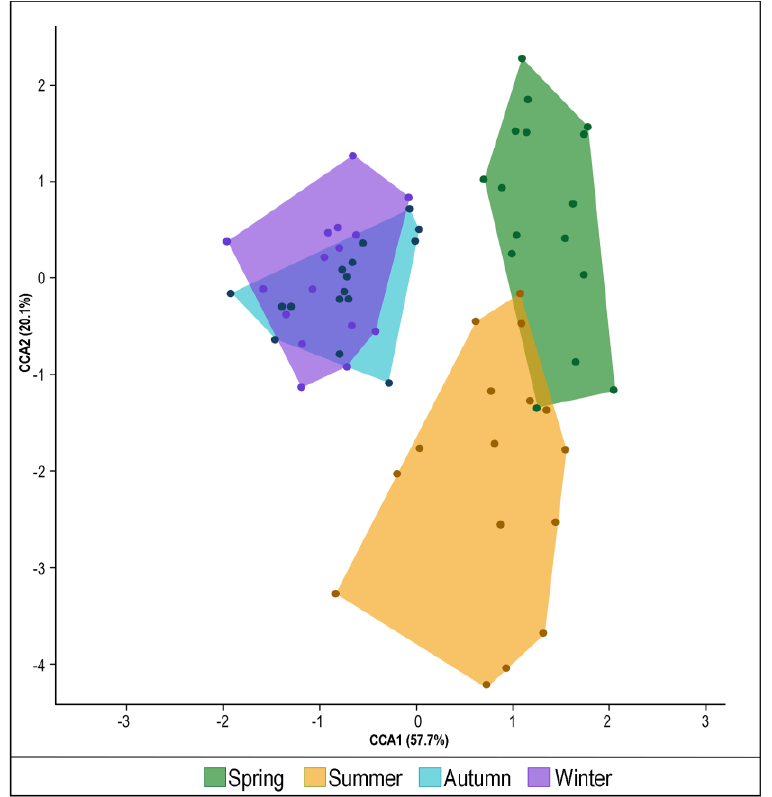
Figure 4. Canonical correspondence analysis (CCA) graph showing the differences between the seasons. The April sampling period represented the spring season, July represented the summer season, October represented the autumn season, and December represented the winter season.